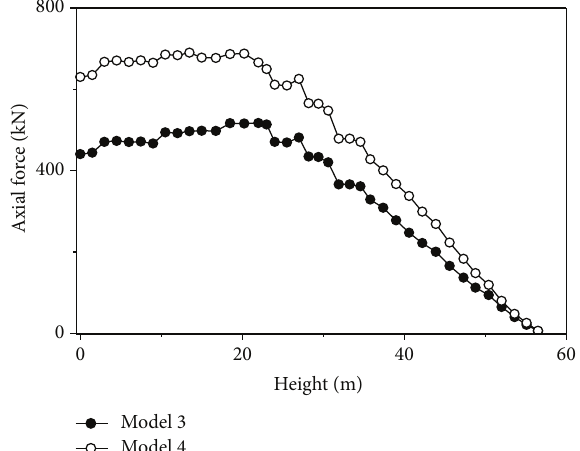
Figure 8: Comparison of the maximum axial forces of the transmission towers of the two models of the tension type.